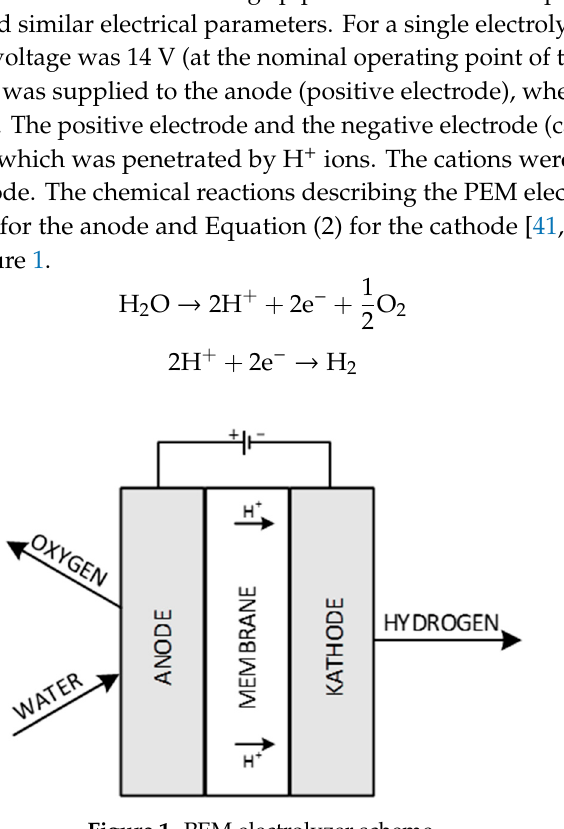
Figure 1. PEM electrolyzer scheme.